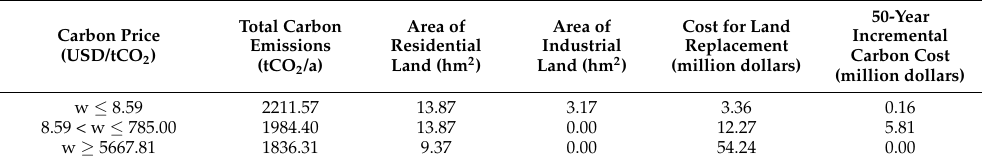
Table 7. Optimized house and industrial land replacement schemes under different carbon